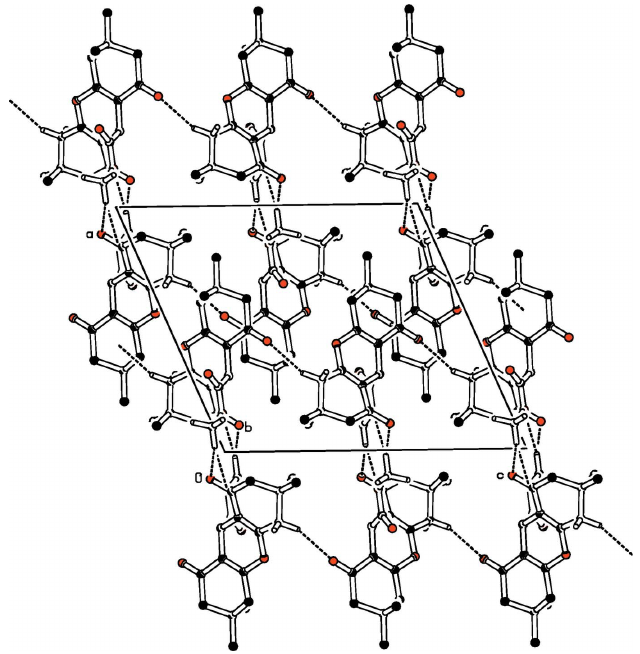
Figure 2 Partial packing diagram of the title compound with a view along the b axis. Most of the hydrogen atoms omitted for clarity. Hydrogen bonds are depicted with dashed lines.